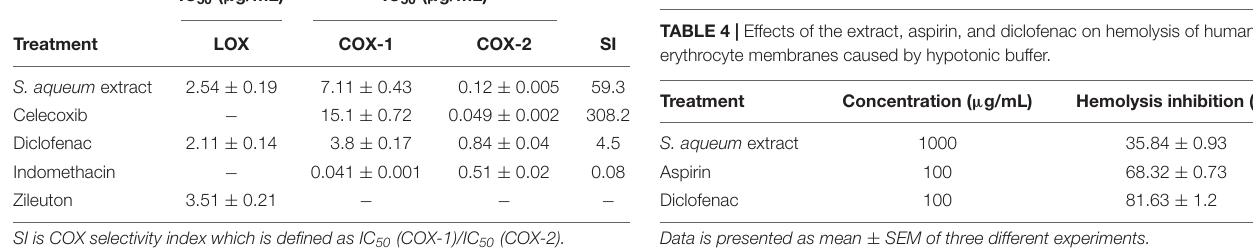
TABLE 3 | Inhibition activities of the extract on LOX, COX-1, and COX-2 enzymes. IC 50 ( µ g/mL) IC 50 ( µ g/mL)